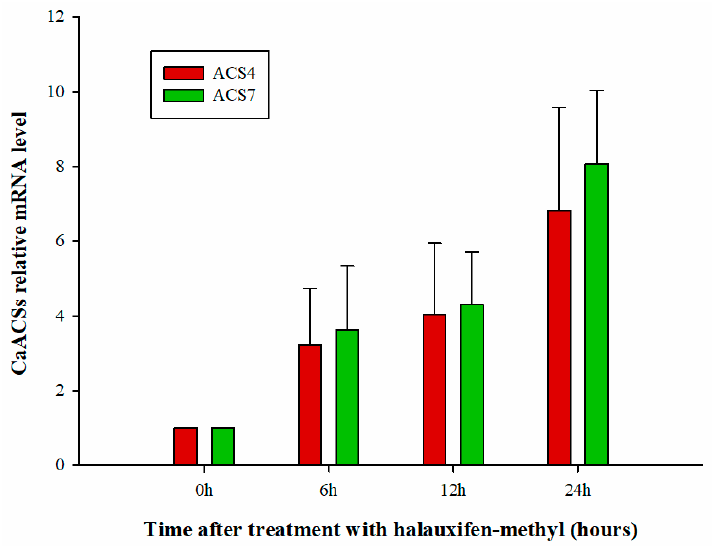
Figure 4. The GaACS4 and GaACS7 gene expression patterns in G. aparine at 0, 6, 12, and 24 h after treatment with 5 μ M of halauxifen-methyl. Vertical bars represent the standard errors of the means.